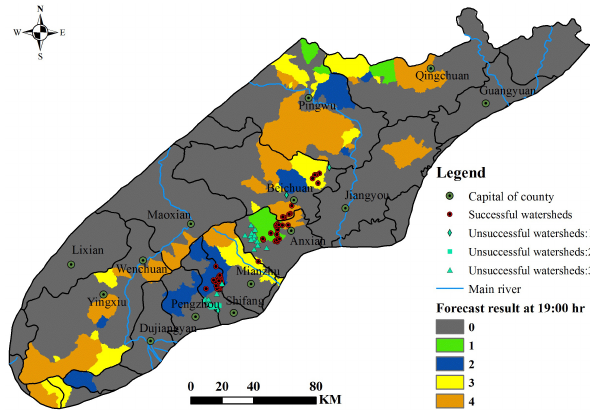
Figure 9. Predicted distribution of 24h of cumulative precipitation. Figure 10. Prediction results of the debris-flow prediction system based on the water–soil coupling mechanism.